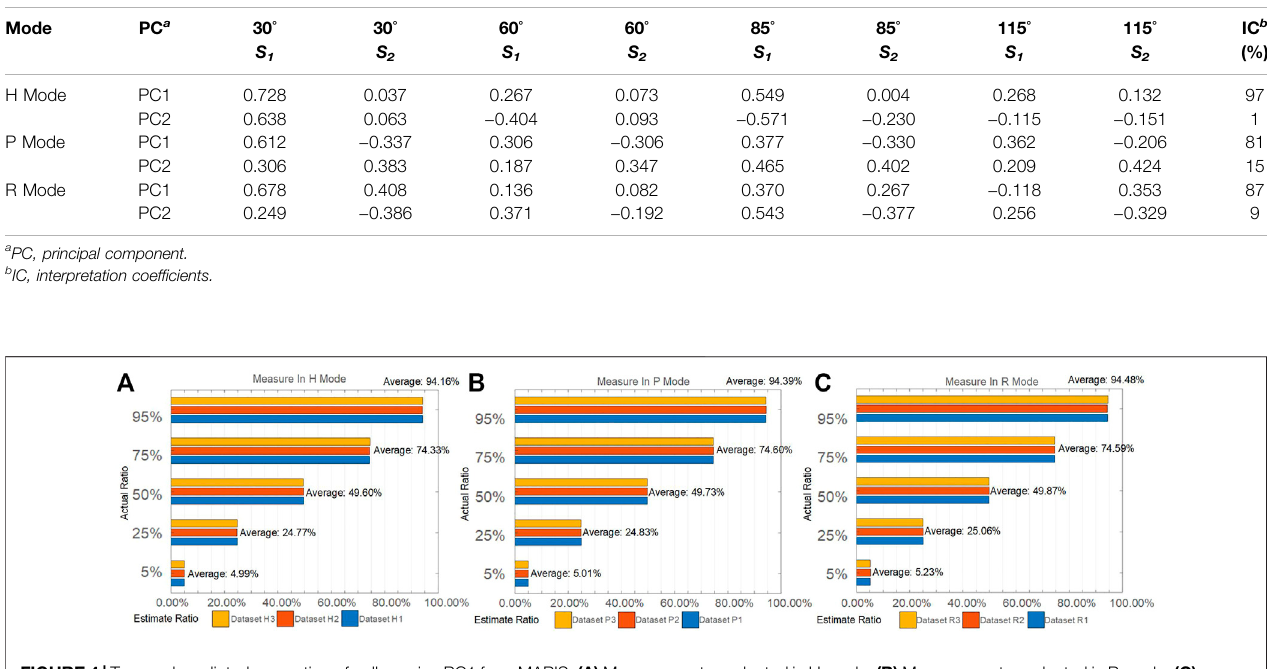
Frontiers in Physics |